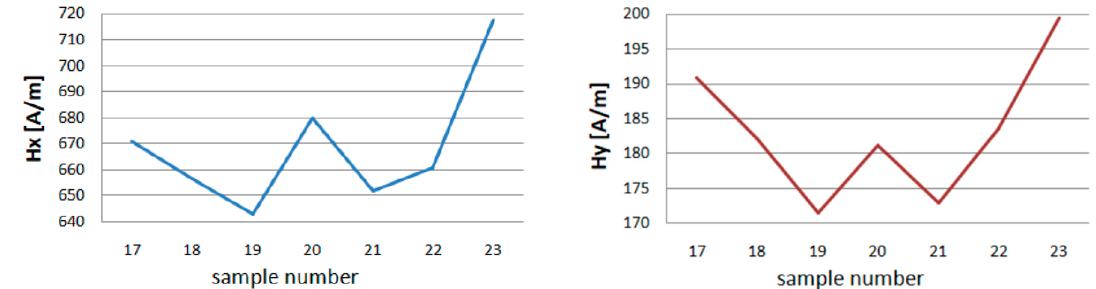
Figure 13. Maximum of tangential component Hx and Hy for experiment E.